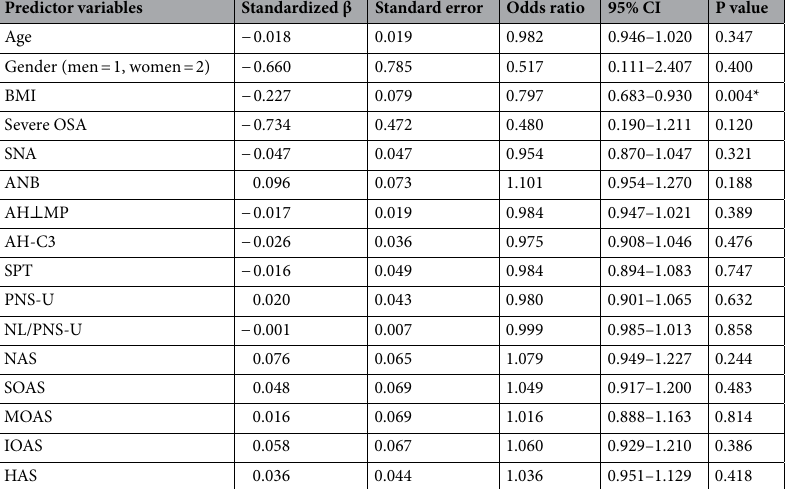
Table 6. Logistic regression analysis of the risk factors on positional dependency. CI, confidence interval; BMI, body mass index; severe OSA, obstructive sleep apnea showing apnea–hypopnea index ≥ 30; SNA, smaller angle which is formed by sella (S), nasion (N), and A point; ANB, smaller angle which is formed by A point, nasion (N), and B point; AH ⊥ MP, the perpendicular distance between AH and Go-Me line; AH-C3, the distance between AH and the third vertebra; SPT, maximum width of soft palate which is perpendicular to PNS-U line; PNS-U, the distance between PNS and U; NL/PNS-U, smaller angle between ANS-Pm line and PNS-U line; NAS, nasal airway space; SOAS, superior oral airway space; MOAS, middle oral airway space; IOAS, inferior oral airway space; HAS, hyoid airway space. *Significant difference: p < 0.05.